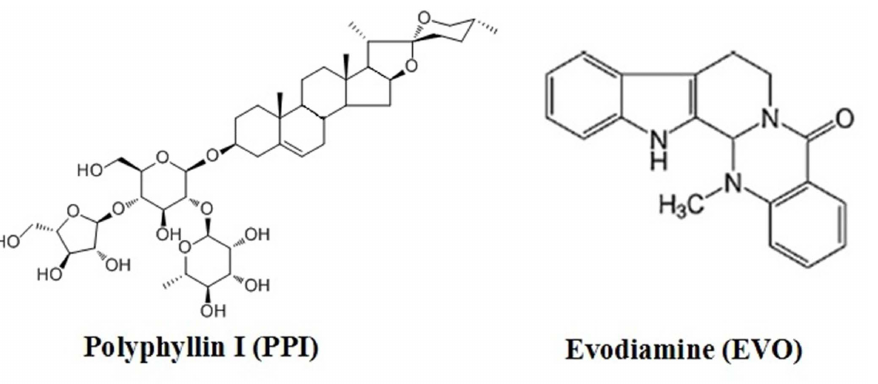
Figure 1. The chemical structure of PPI and EVO. PPI molecular weight: 855.02; molecular structure: C44H70O16. EVO molecular weight: 303.36; molecular structure: C19H17N3O.